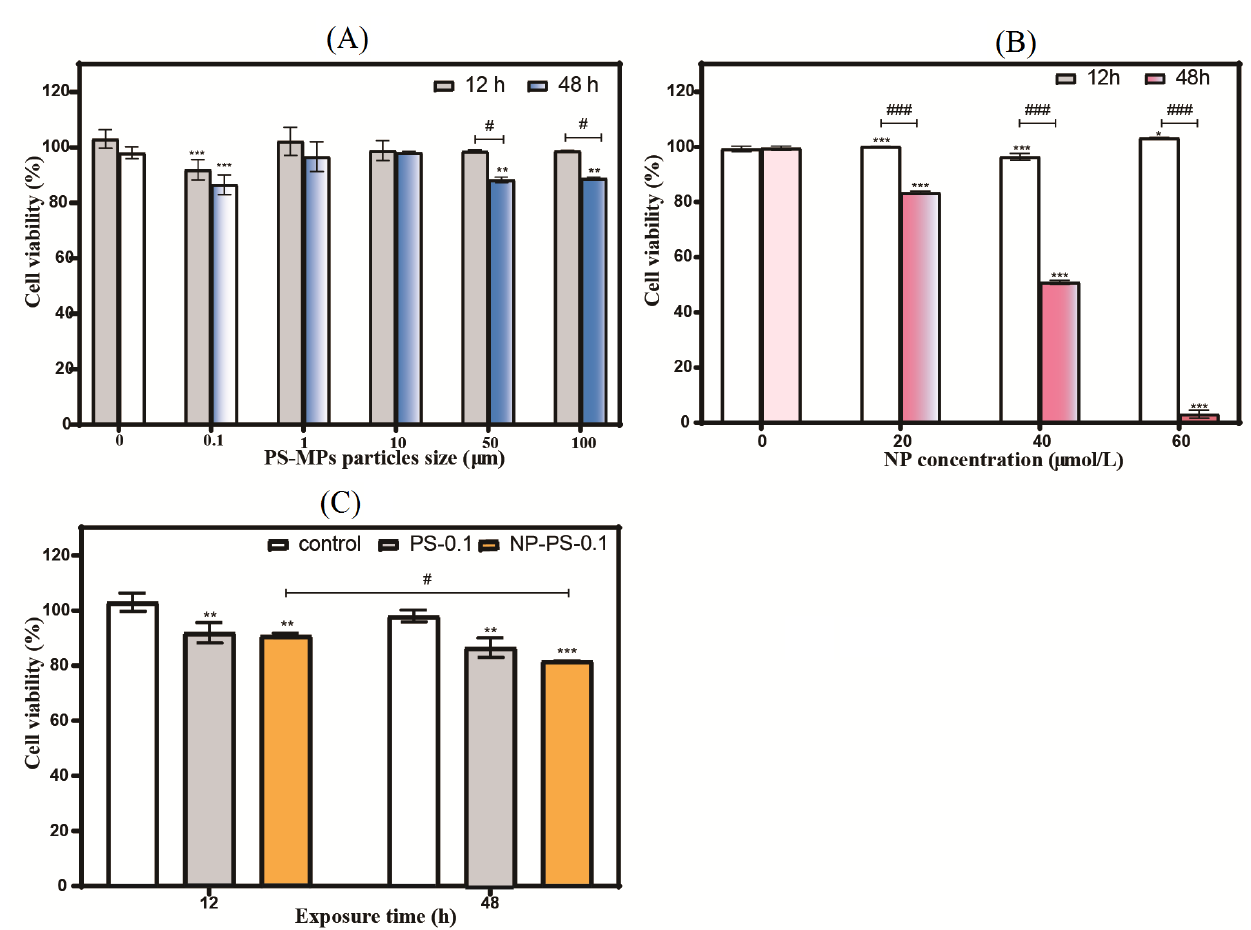
Figure 4. Effects of PS-MPs, NP, and synergistics on the cell viability of Caco-2 cells. Cells were incubated alone with different particle sizes of 500 mg/L PS-MPs ( A ) and different concentrations of NP ( B ) for 12 and 48 h. The effect of 0.1 µ m PS-MPs alone and in combination with NP on Caco-2 cell viability at 12 h and 48 h ( C ). Cell viability was measured by CCK-8 assay. * indicates the significant difference between the treatment group and the control group (* p < 0.05, ** p < 0.001, *** p < 0.0005). # indicates the significant difference between the marked groups ( # p < 0.05, ### p < 0.0005).